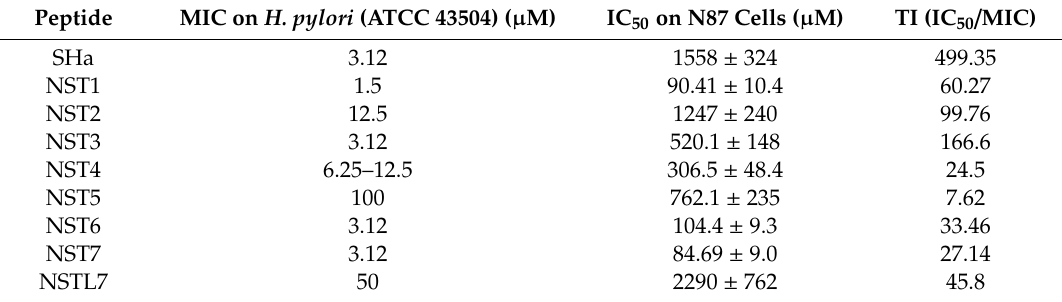
Table 3. Evaluation of the antibacterial activity of temporin-SHa and its analogs against H. pylori (ATCC 43504) and of their in vitro toxicity against human N87 cells by the inhibitory concentrations reducing 50% of the cell viability (IC 50 values). Therapeutic index (TI) was calculated by dividing the IC 50 by